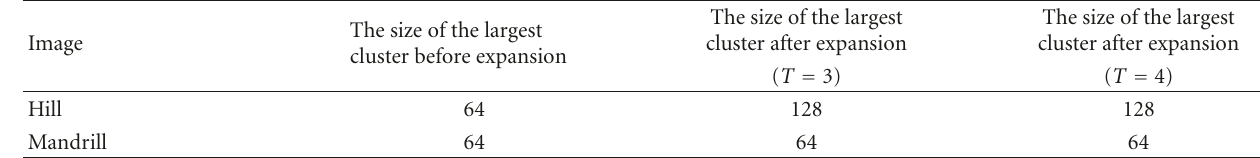
Table 2: The size of the largest clusters before and after cluster expansion.